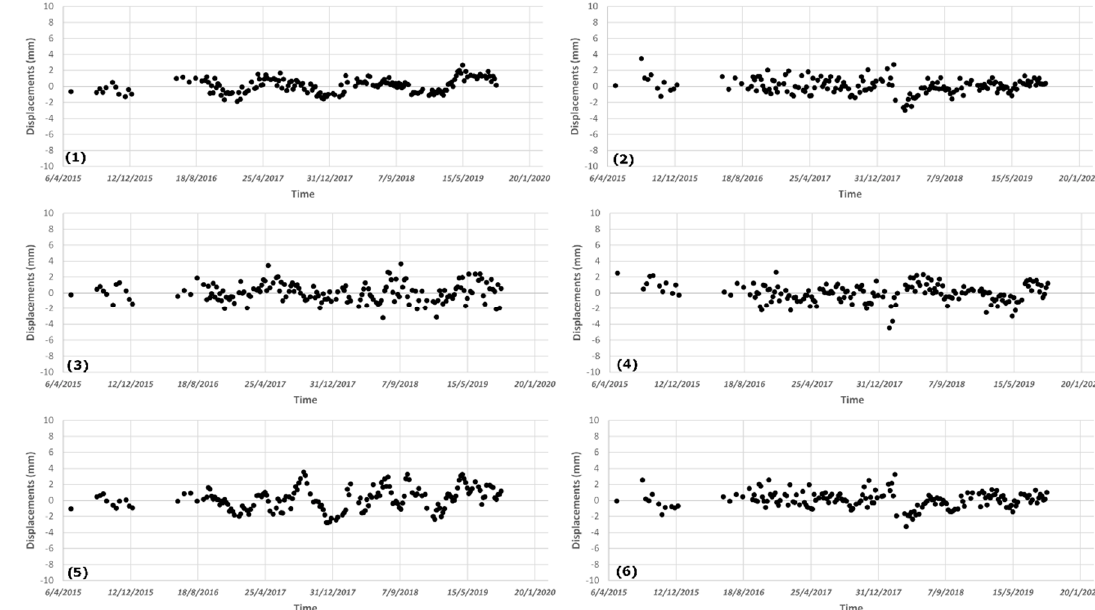
Figure 5. A sample of LOS-oriented time series provided by the PSI analysis in the vicinity of BOLG station. Each sub-figure (1–6) represents the time series of a single PS.